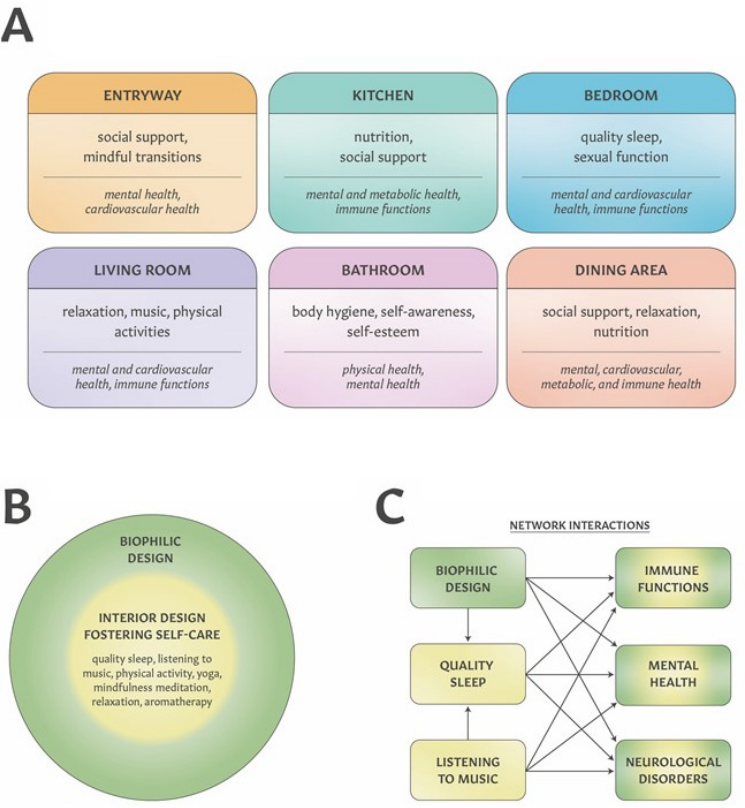
Figure 1. Graphical representation of transforming residential indoor spaces into therapeutic